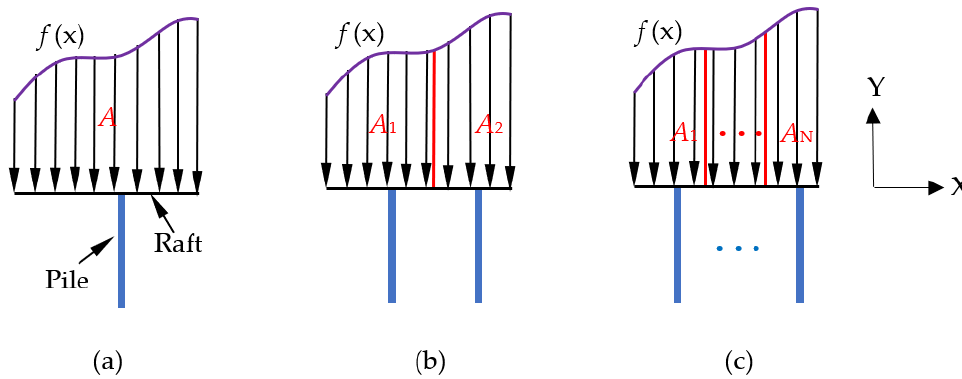
Figure 1. Two-dimensional plane problem of piled raft foundations: ( a ) piled raft with one pile; ( b ) piled raft with two piles; ( c ) piled raft with N piles.